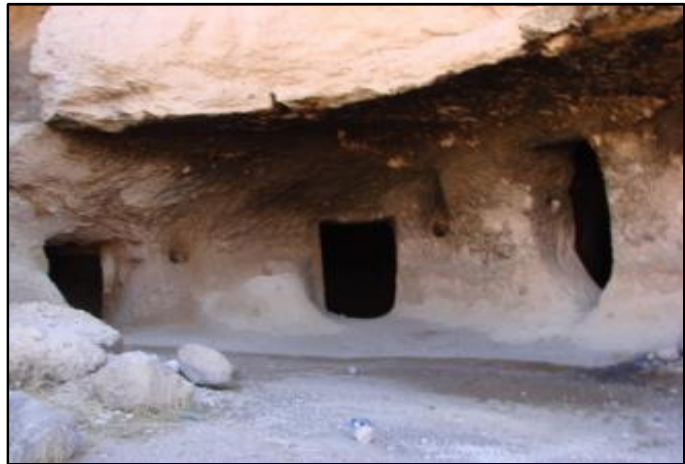
Figure 12. Mass excavation technique in Meymand houses.